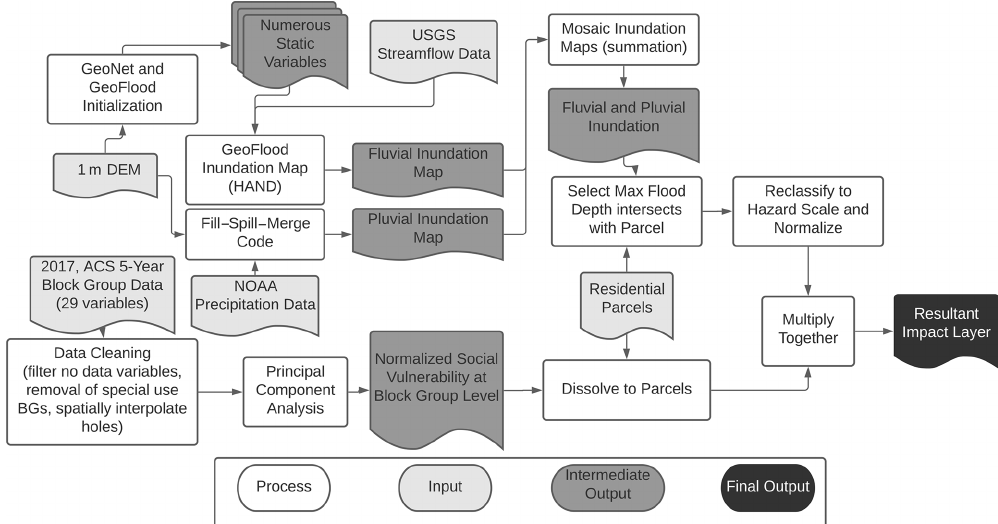
Figure 2. Complete workflow of our approach, including fluvial/pluvial inundation estimation and SVI calculation. White boxes indicate a process (mathematical function, program, or action), lightly shaded boxes indicate an outside data input, dark shaded boxes indicate an intermediate dataset, and the black box is the final